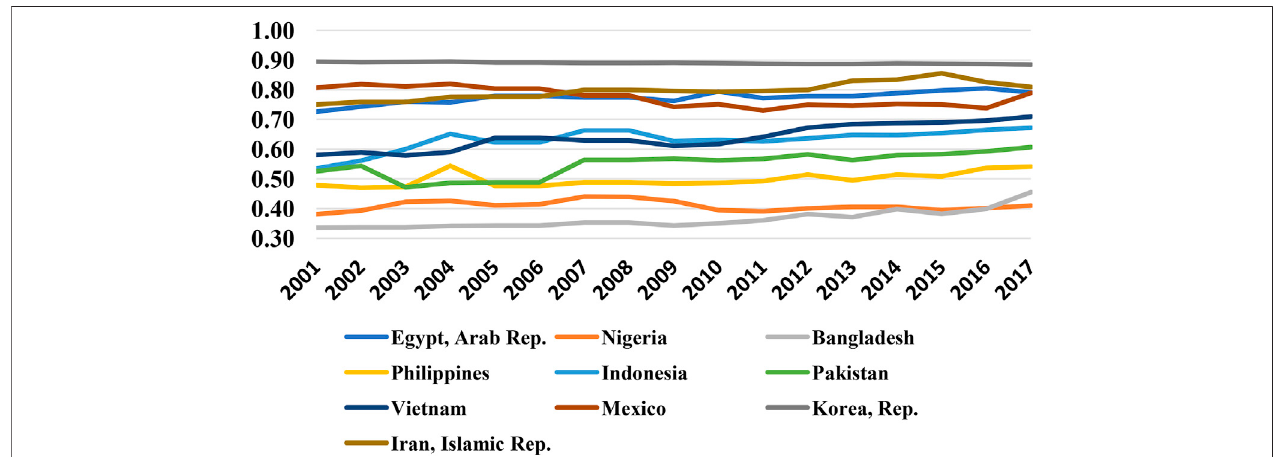
FIGURE 1 | Overall energy poverty index from 2001 to